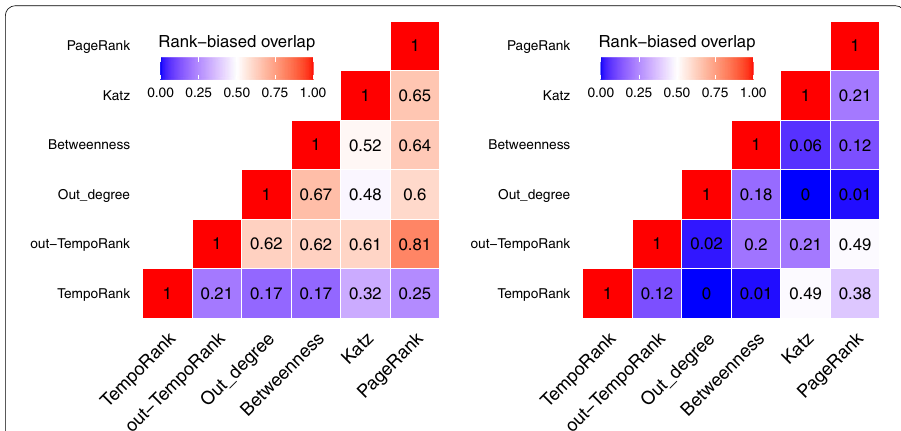
Fig. 5 Rank-biased overlap between rankings according to static and temporal centrality measures on the 2015 BDNI network, complete (left) and reconstructed